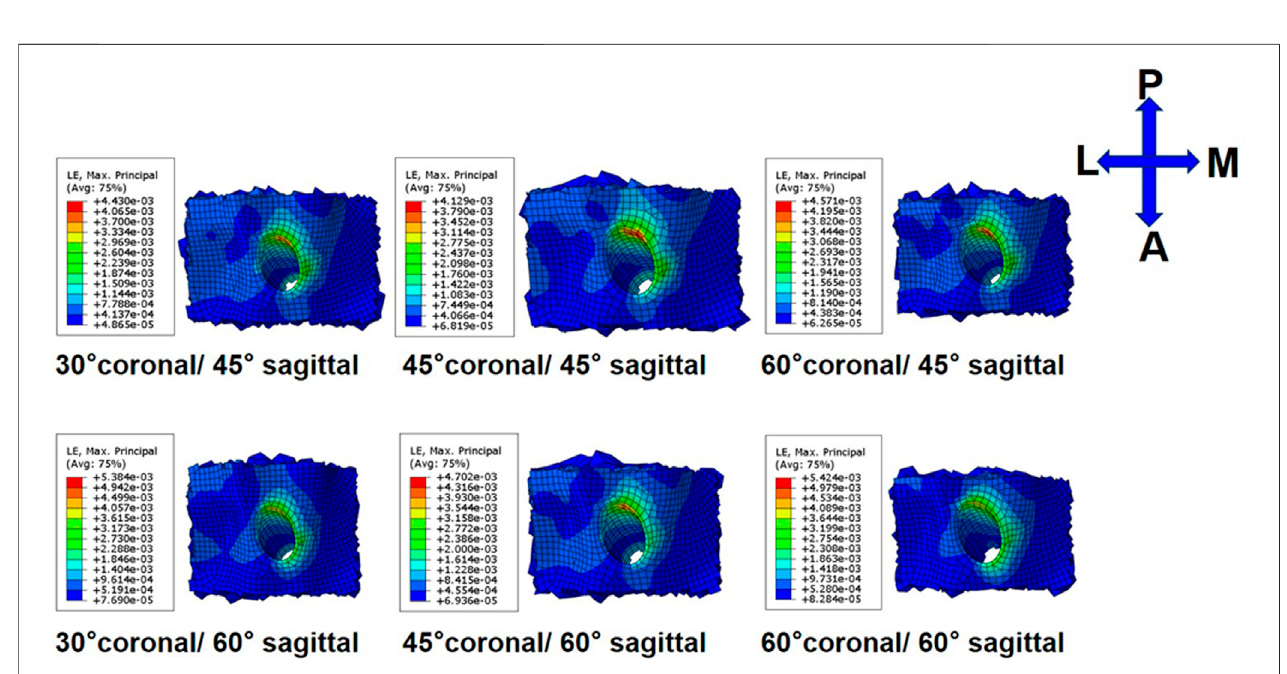
FIGURE 7 | Strain distribution around tibial tunnel entrance following